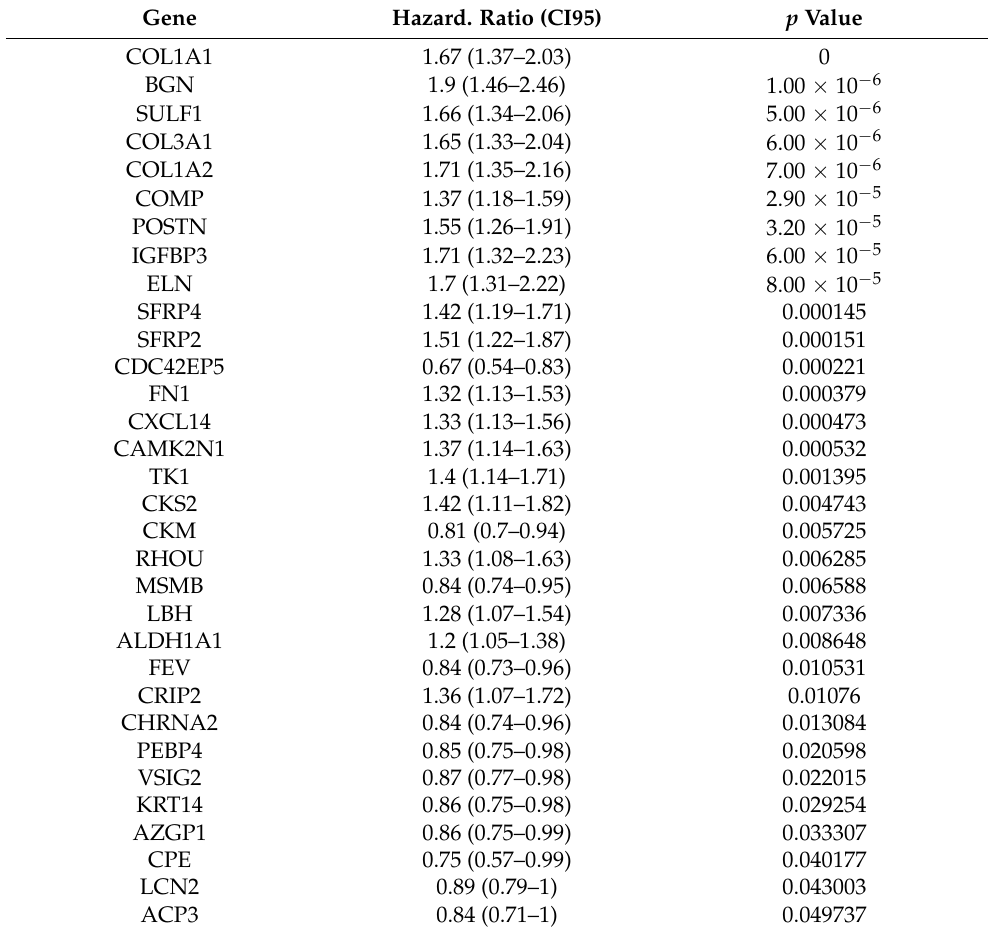
Table 1. Thirty-two genes significantly associated with the BCR free survival of patients in the training set ( n = 487).